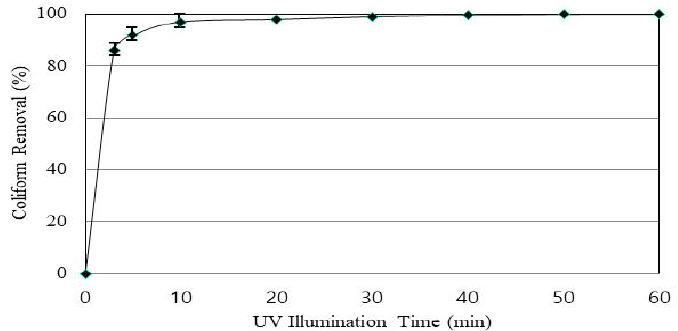
Figure 11. Variation of coliform removal with UV illumination time in photo-assisted Fenton oxidation at the optimal conditions (pH = 3.5, H 2 O 2 = 0.1 M, UV 254 intensity = 3.524 mW/cm 2 ).